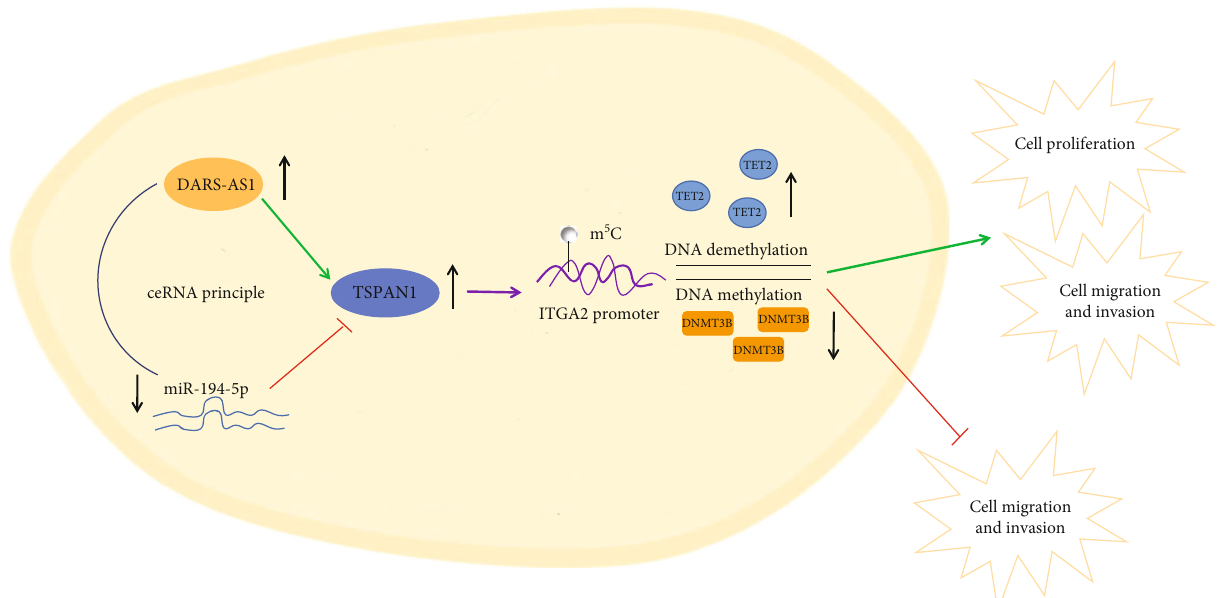
Figure 7: Schematic representation of upregulated lncRNA DARS-AS1 in OC results in increased expression of TSPAN1 via miR-194-5p, which can accelerate tumorigenesis by epigenetically upregulating the expression of ITGA2 via mediating the demethylase and methyltransferase